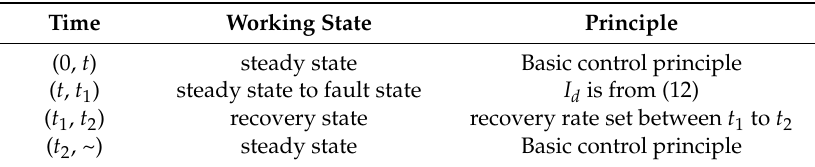
Table 2. Active power control activities [38].